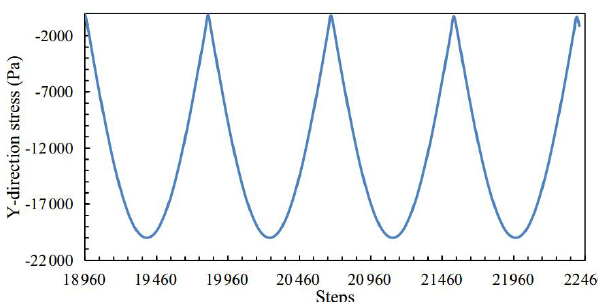
Figure 2. Cyclic loading at the bottom of the tunnel.